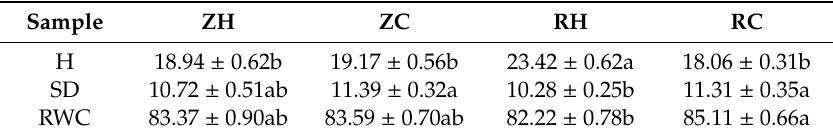
Figure 2. Ca 2 + fluorescence signals localized in di ff erent treatment groups. ( A ) The control group did not contain any treatment (ZH). ( B ) Exogenous Ca 2 + was treated under normal light (ZC). ( C ) Ca 2 + distribution in potatoes under weak light (RH). ( D ) E ff ects of exogenous Ca 2 + treatment on the distribution of endogenous Ca 2 + in potatoes under weak light (RC). Table 1. Height (H), stem diameter (SD) and relative water content (RWC) under di ff erent treatments. Treatments are ZH (Control), RH (Weak light), ZC (Ca 2 + ), and RC (Weak light + Ca 2 + ). Letters indicate significant di ff erences at p < 0.05 according to Duncan’s multiple range